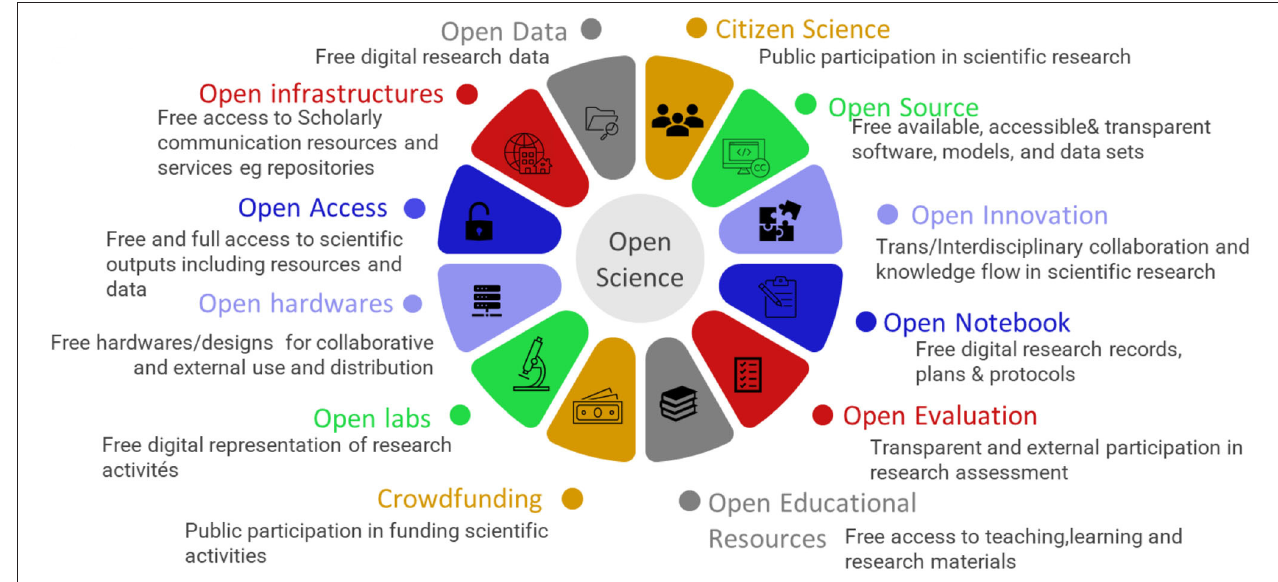
FIGURE 1 | The elements of open science as adapted from the UNESCO recommendation